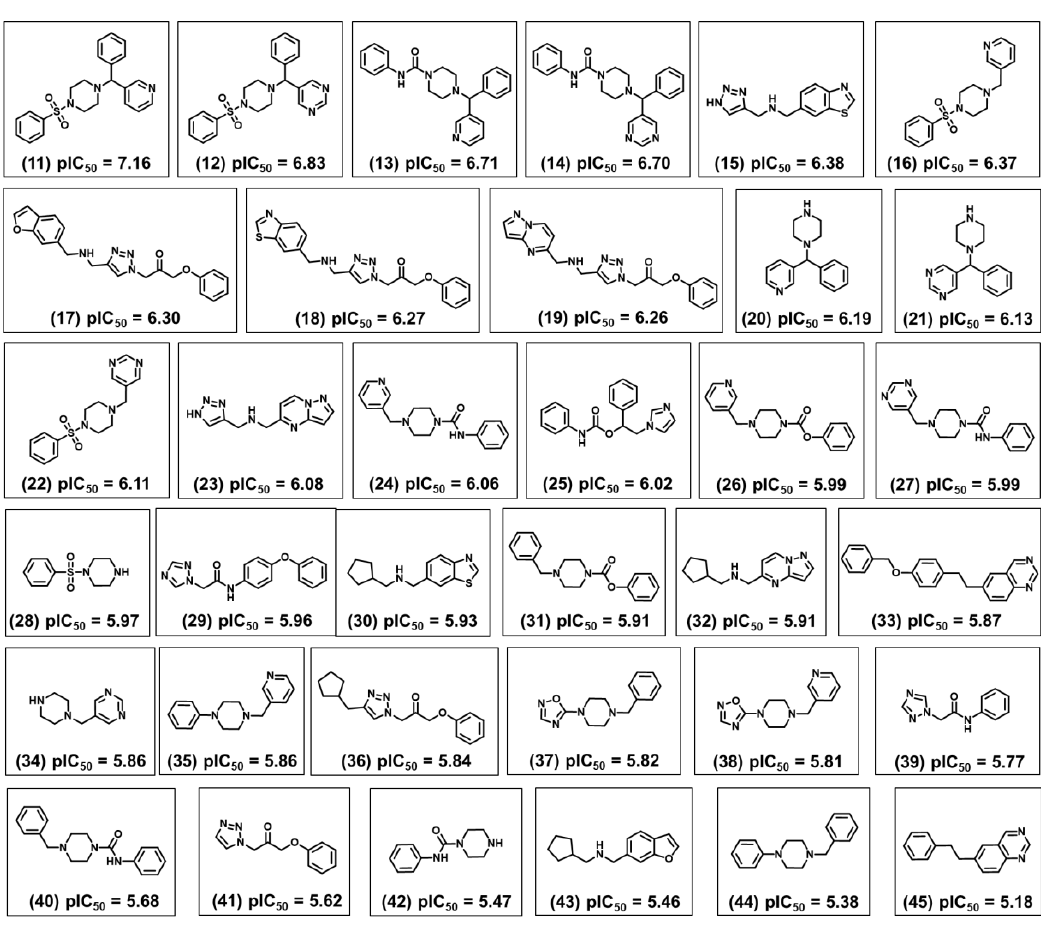
Figure 11. Fragments extracted from active compounds (pIC 50 > 6) and the respective ANN-predicted trypanocidal activity.